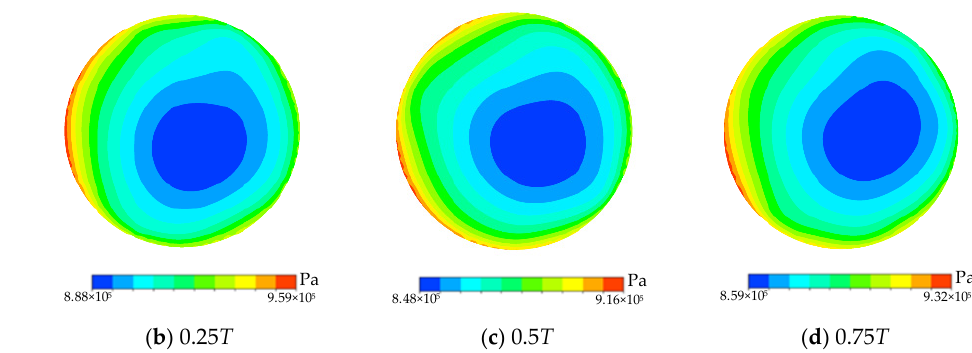
Figure 5. Pressure distribution of draft tube of Plane 4.